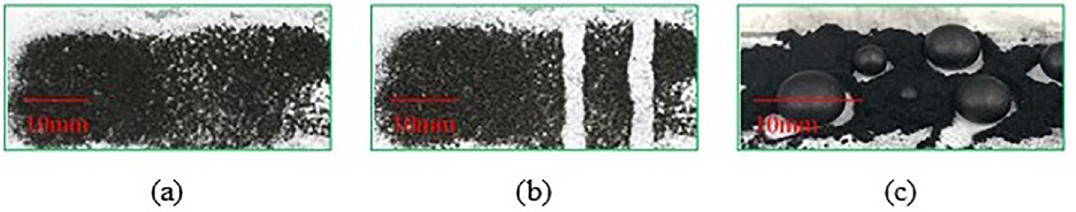
Figure 6. Self-cleaning performance of the modified surface (PMMA+NP+POTS). (a) coal powder on the surface, (b) self-cleaning performance on tilted surface, (c) self-cleaning performance on horizontal